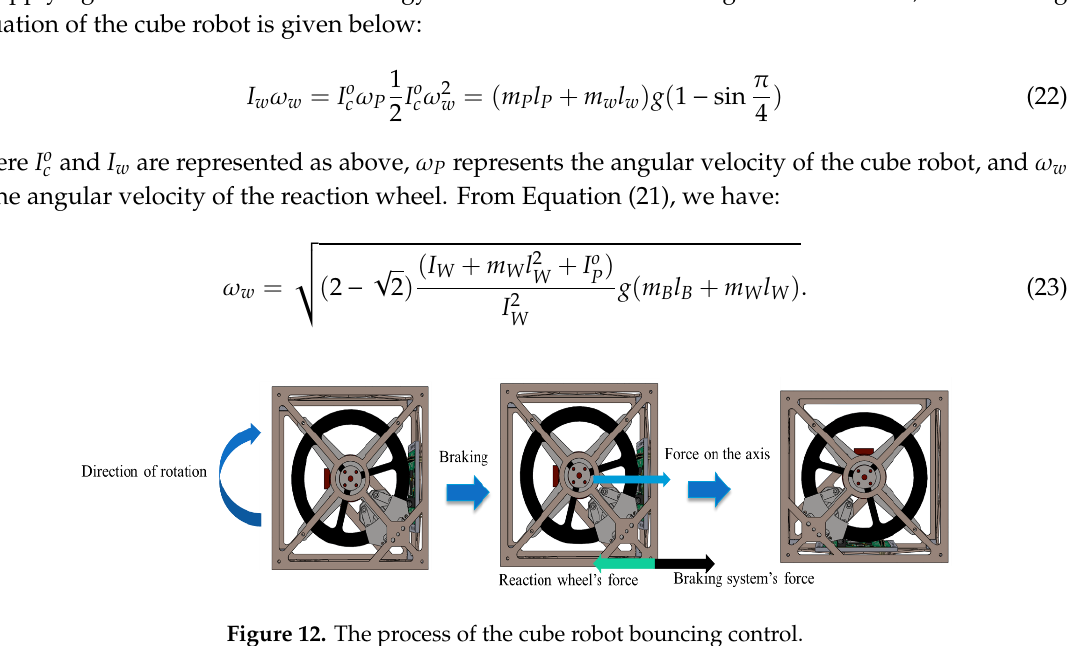
Figure 12. The process of the cube robot bouncing control.